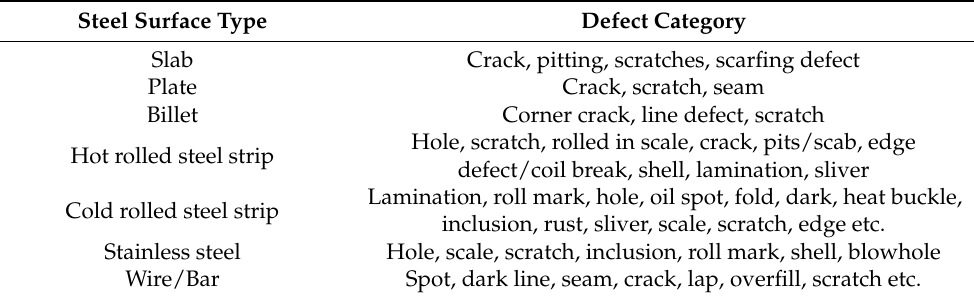
Table 1. Statistics of the steel surface defect categories.